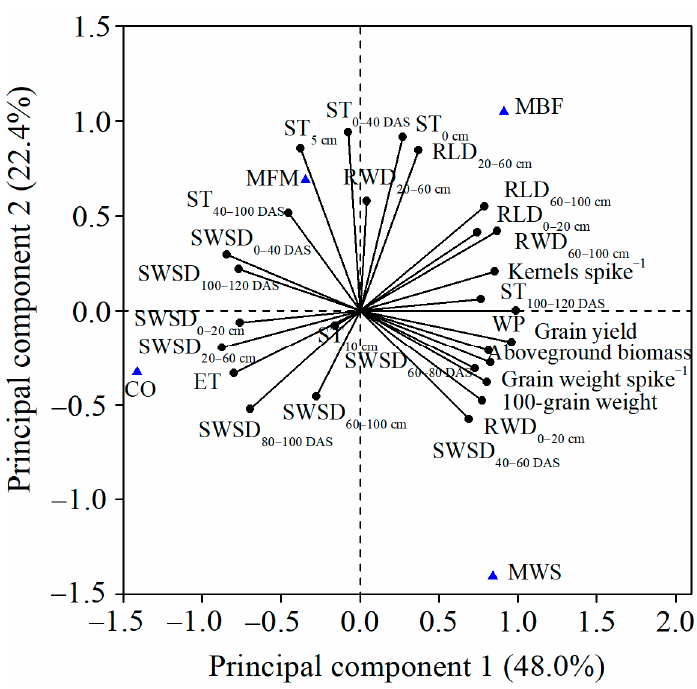
Figure 8. Principal component analysis (PCA) for various treatments as a function of soil and crop parameters. Treatment abbreviations are the same as those described in Figure 2. ST 0–40 DAS , ST 40–100 DAS , and ST 100–120 DAS : soil temperature at 0–40, 40–100, and 100–120 DAS in the 0–10 cm soil layer; ST 0 cm , ST 5 cm , and ST 10 cm : soil temperature at 0, 5, and 10 cm depth during the whole maize growth seasons; SWSD 0–40 DAS -SWSD 100–120 DAS : soil water storage depletion at 0–40, 40–60, 60–80, 80–100, and 100–120 DAS; SWSD 0–20 cm , SWSD 20–60 cm , and SWSD 60–100 cm : soil water storage depletion from sowing to harvest at 0–20, 20–60, and 60–100 cm depths. RLD 0–20 cm , RLD 20–60 cm and RLD 60–100 cm : root length density at 0– 20, 20–60, and 60–100 cm depths at maturity; RWD 0–20 cm , RWD 20–60 cm , and RWD 60–100 cm : root weight